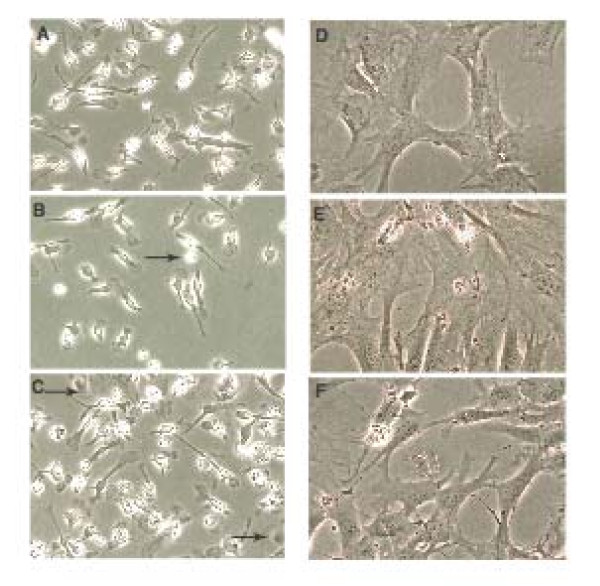
Isolation of Bone Marrow Stem Cells.  Bone marrow was aspirated from tibia and fibula of mice (4 per group) at age 2m, 8m, and 26m.  1(A-C) shows cells at the first passage from 2m, 8m, and 26m ages respectively.  Morphologies of the cells was heterogenous at this stage. 1(D-F) shows cells after 10 passages again a 2, 8 and 26m respectively, cells at this passage were homogeneous with a flattened morphology.